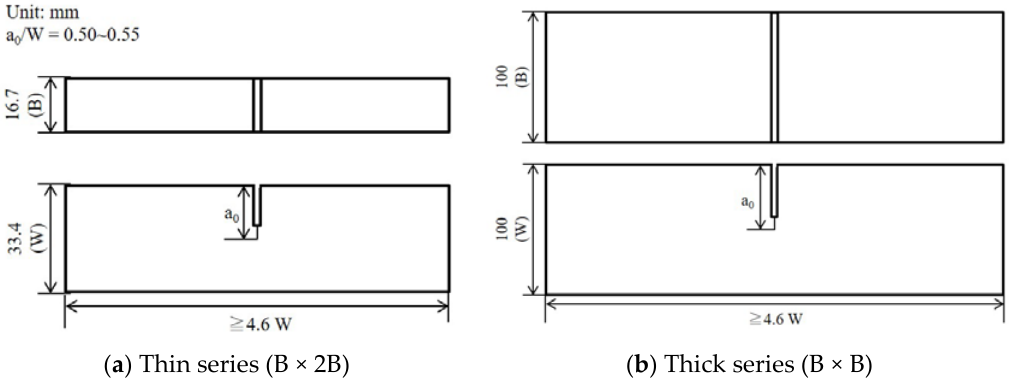
Figure 4. Crack tip opening displacement (CTOD) specimen (three-point bending type) sizes of thin series ( a ) and thick series ( b ).